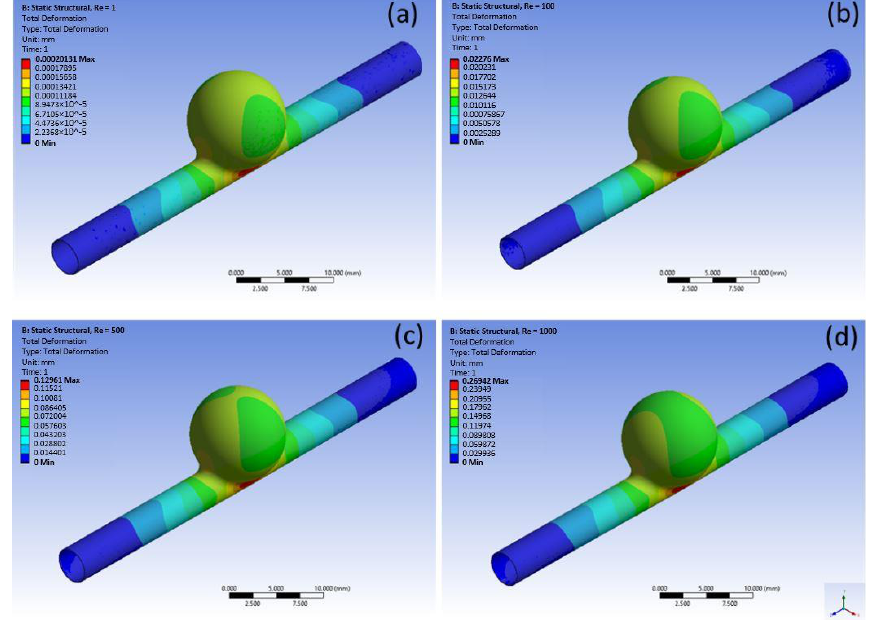
Figure 13. Total displacement: ( a ) Re = 1; ( b ) Re = 100; ( c ) Re = 500; ( d ) Re = 1000.